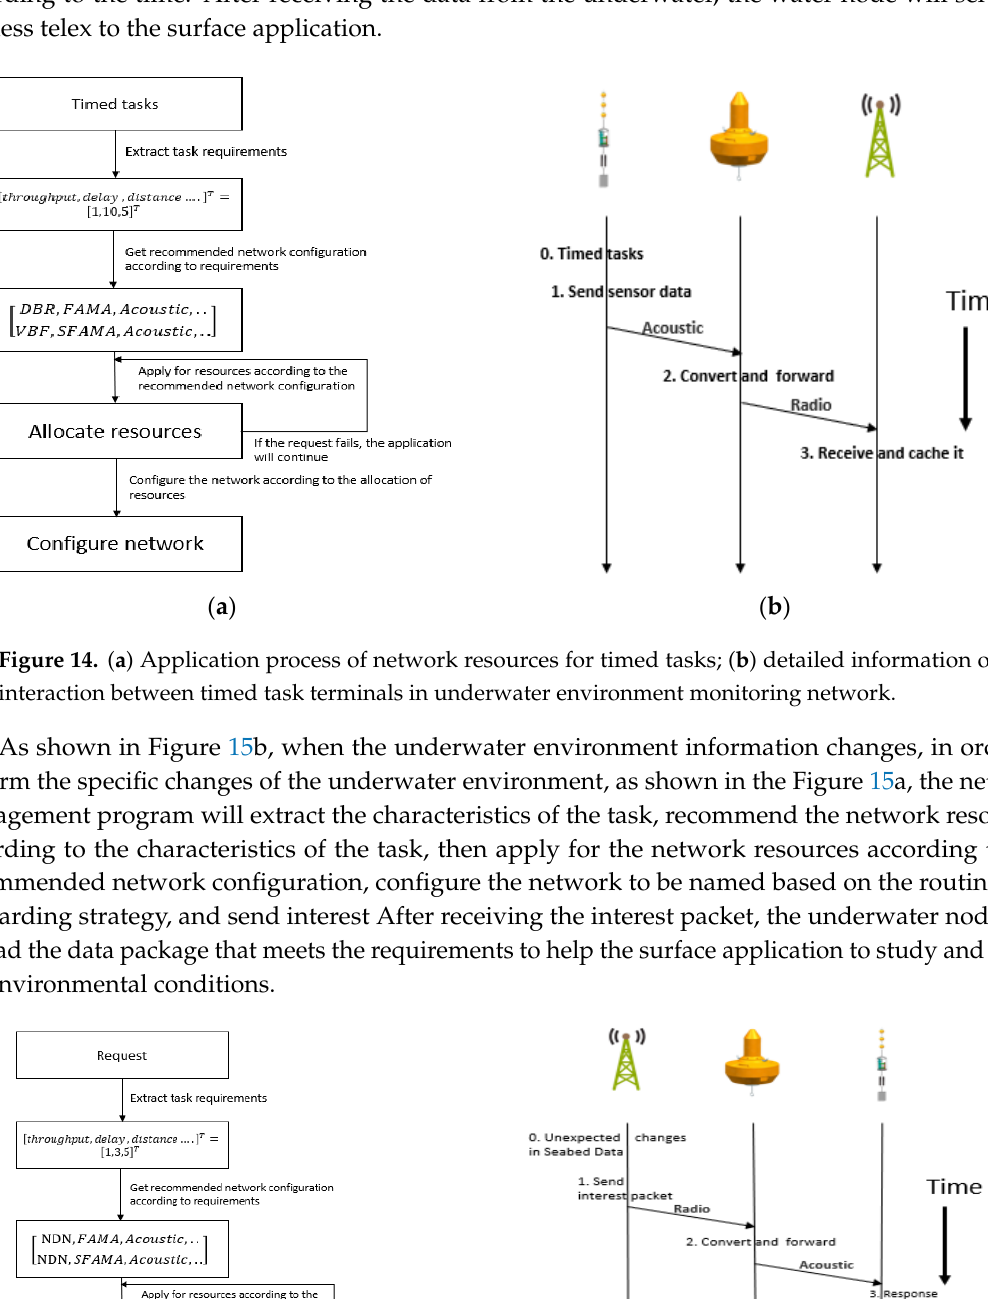
( b ) Figure 16. ( a ) Data collection application network resource request; ( b ) detailed information on the interaction between terminals of underwater data collection network. As shown in Figure 17b, when the surface application is in urgent need of data in a certain area of the seabed, as shown in Figure 17a, the network management program will extract the characteristics of the task, recommend the network resources according to the characteristics of the task, then apply for the network resources according to the recommended network configuration,